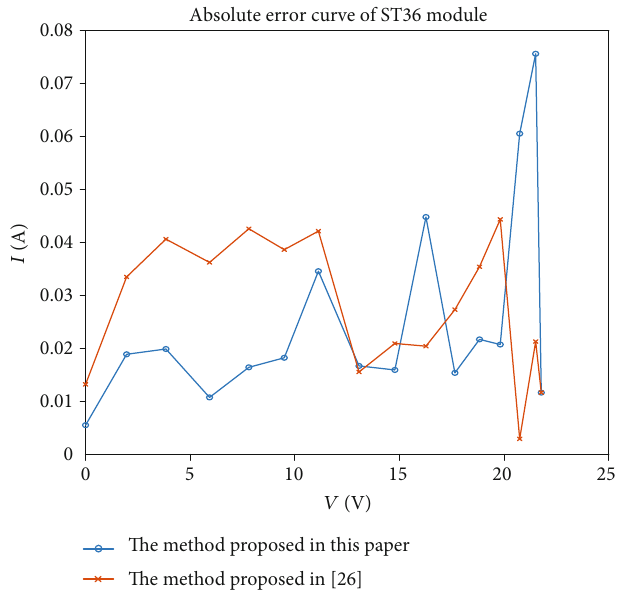
Figure 12: Absolute error comparison of ST36 modules with di ff erent extraction methods under